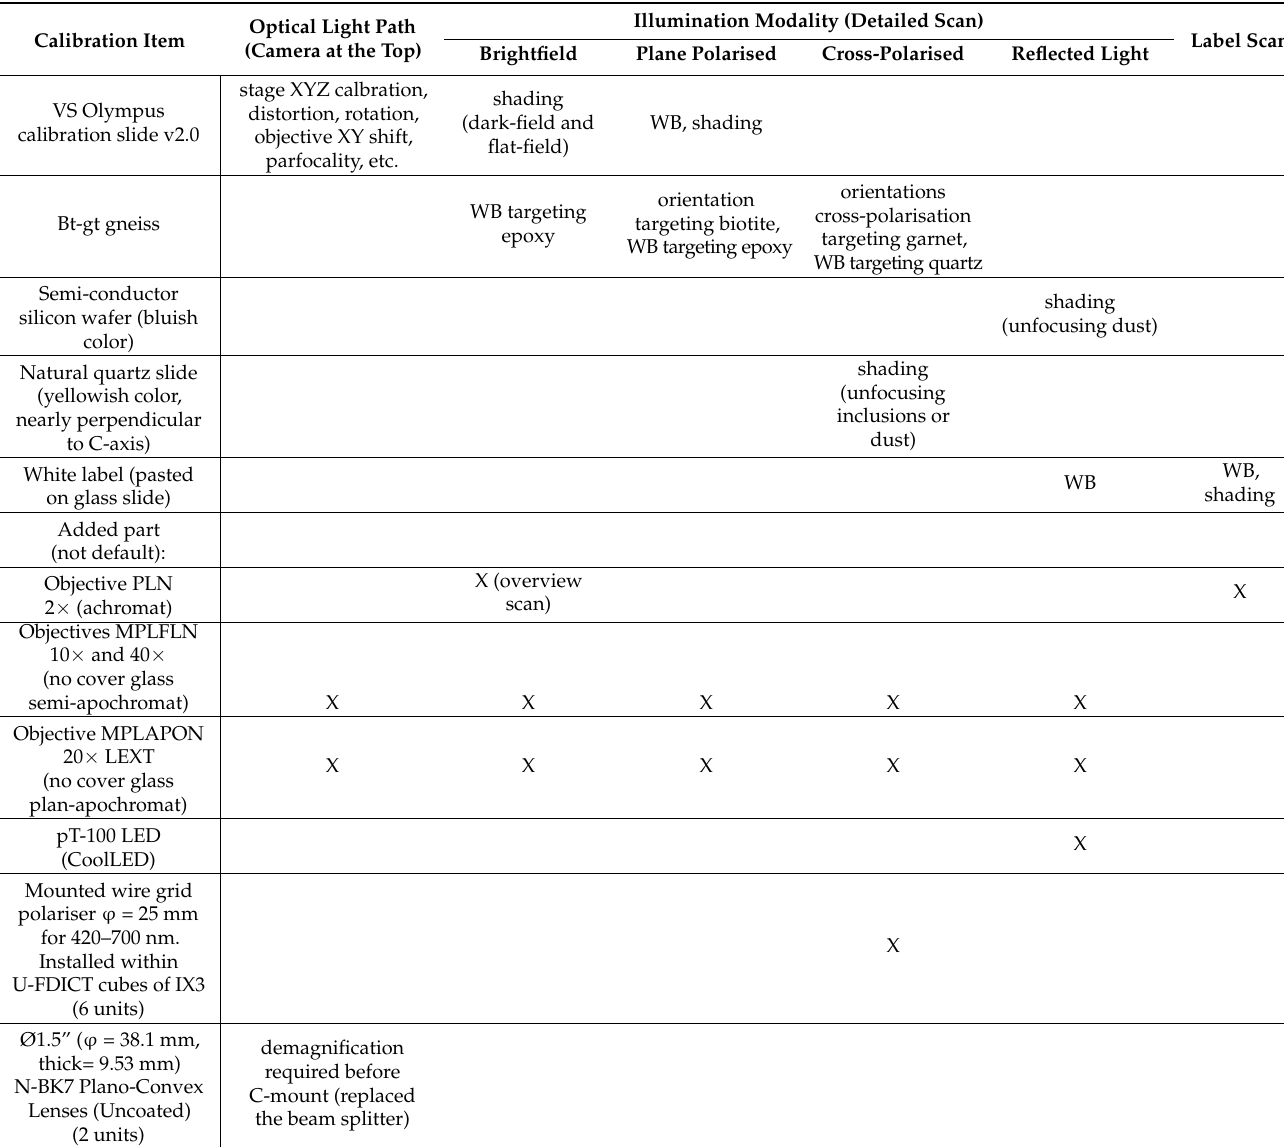
Table 1. Repurposed VS200 calibration items and